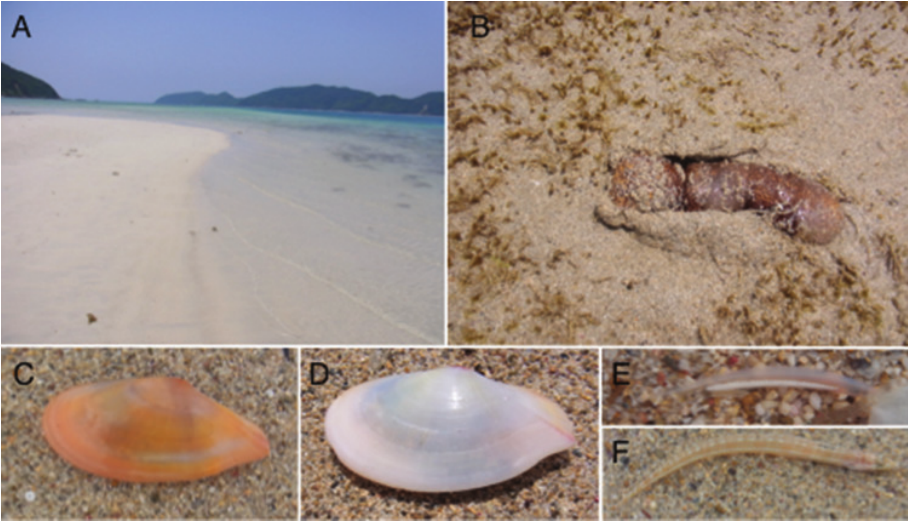
Figure 2. A panorama of the sand flat of Edateku Island at spring low tide ( A ) and the sand-dwelling organisms therein ( B–F ): B Bohadschia bivittata C Pharaonella amanyu D Tonganaella tongana E Bran- chiostoma belcheri F Trichonotus elegans